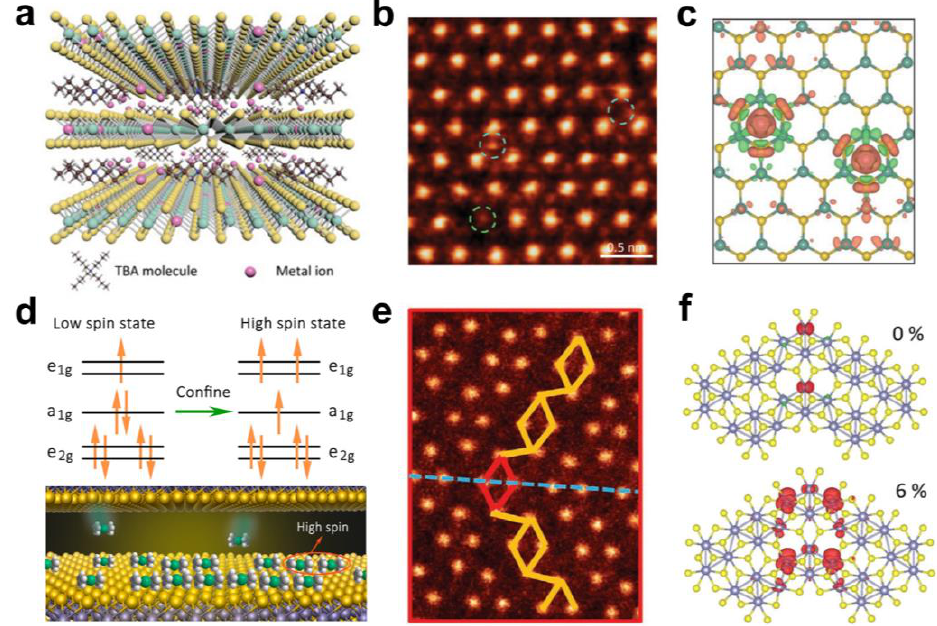
Figure 7. ( a ) Schematic diagram of Co-TaS 2 molecular superlattice structure. Reproduced with permission from Ref. [26]. Copyright 2020, Wiley − VCH. ( b ) The high-angle annular dark-field scanning transmission electron microscopy image of the surface of a Co-TaS 2 superlattice flake. Reproduced with permission from Ref. [26]. Copyright 2020, Wiley − VCH. ( c ) Schematic diagram of the spin den- sity of Co atoms in the hollow position of monolayer TaS 2 . Reproduced with permission from Ref.